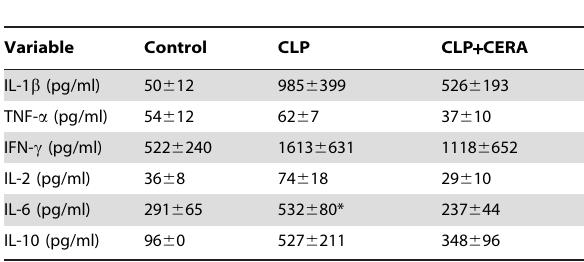
Table 3. Effects of continuous erythropoietin receptor activator on plasma levels of pro-inflammatory cytokines at 24 h after cecal ligation and